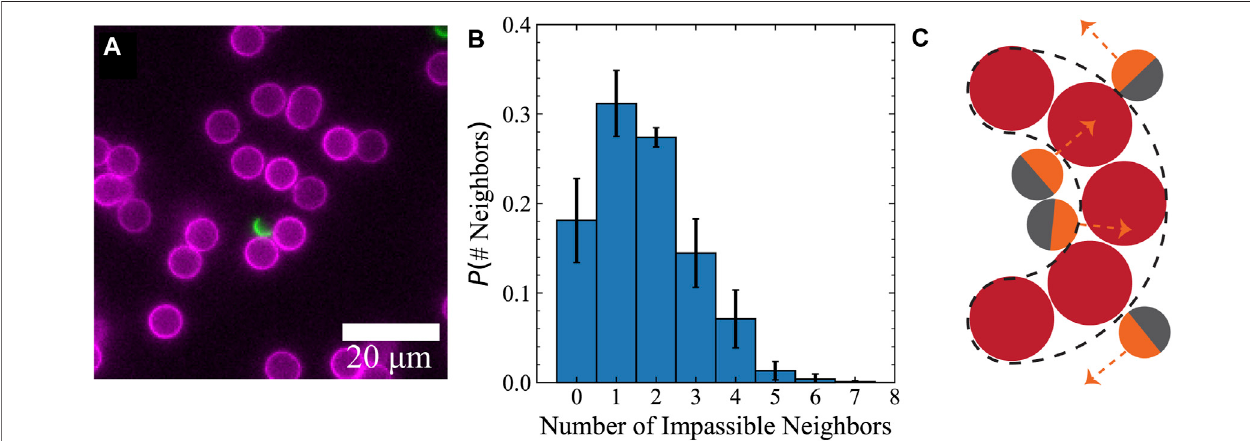
FIGURE3| ActiveJanusparticlesspentasigni fi cantamountoftimenearobstacleclustersthatformedcurvedboundarieswithnarrowconstrictionsites. (A) Image of an active Janus particle interacting with a grouping of obstacles that forms a curved boundary with concavity. (B) Histogram quantifying obstacle particle grouping. Numberofimpassibleneighborsisfoundbycountingalltheobstacleneighborswithindistance4 μ m fromareferenceobstacle ’ ssurface.Groupsofobstacleswithinthis distance are impassible by a Janus swimmer with diameter 4 μ m . Error bars are the standard deviation from six independent experiments. (C) Schematic demonstrating the concave shape formed by the packing of